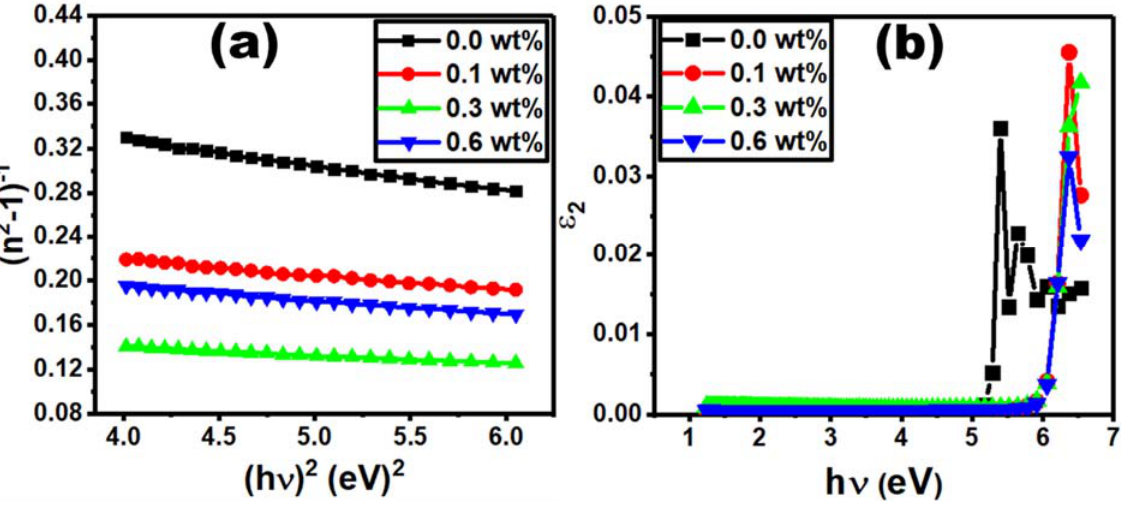
Figure 8. Plot of ( a ) reflectance and ( b ) refractive index for PVC/PVP films with different Er 2 O 3 con ‐ centrations.